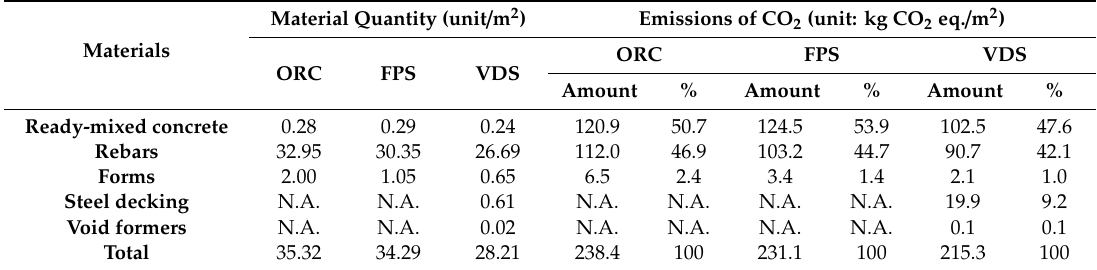
Table 7. Material quantity and carbon dioxide emissions per square meter.